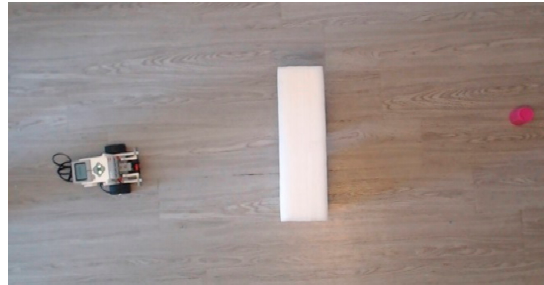
Figure 6. The graphical representation of the robot field.